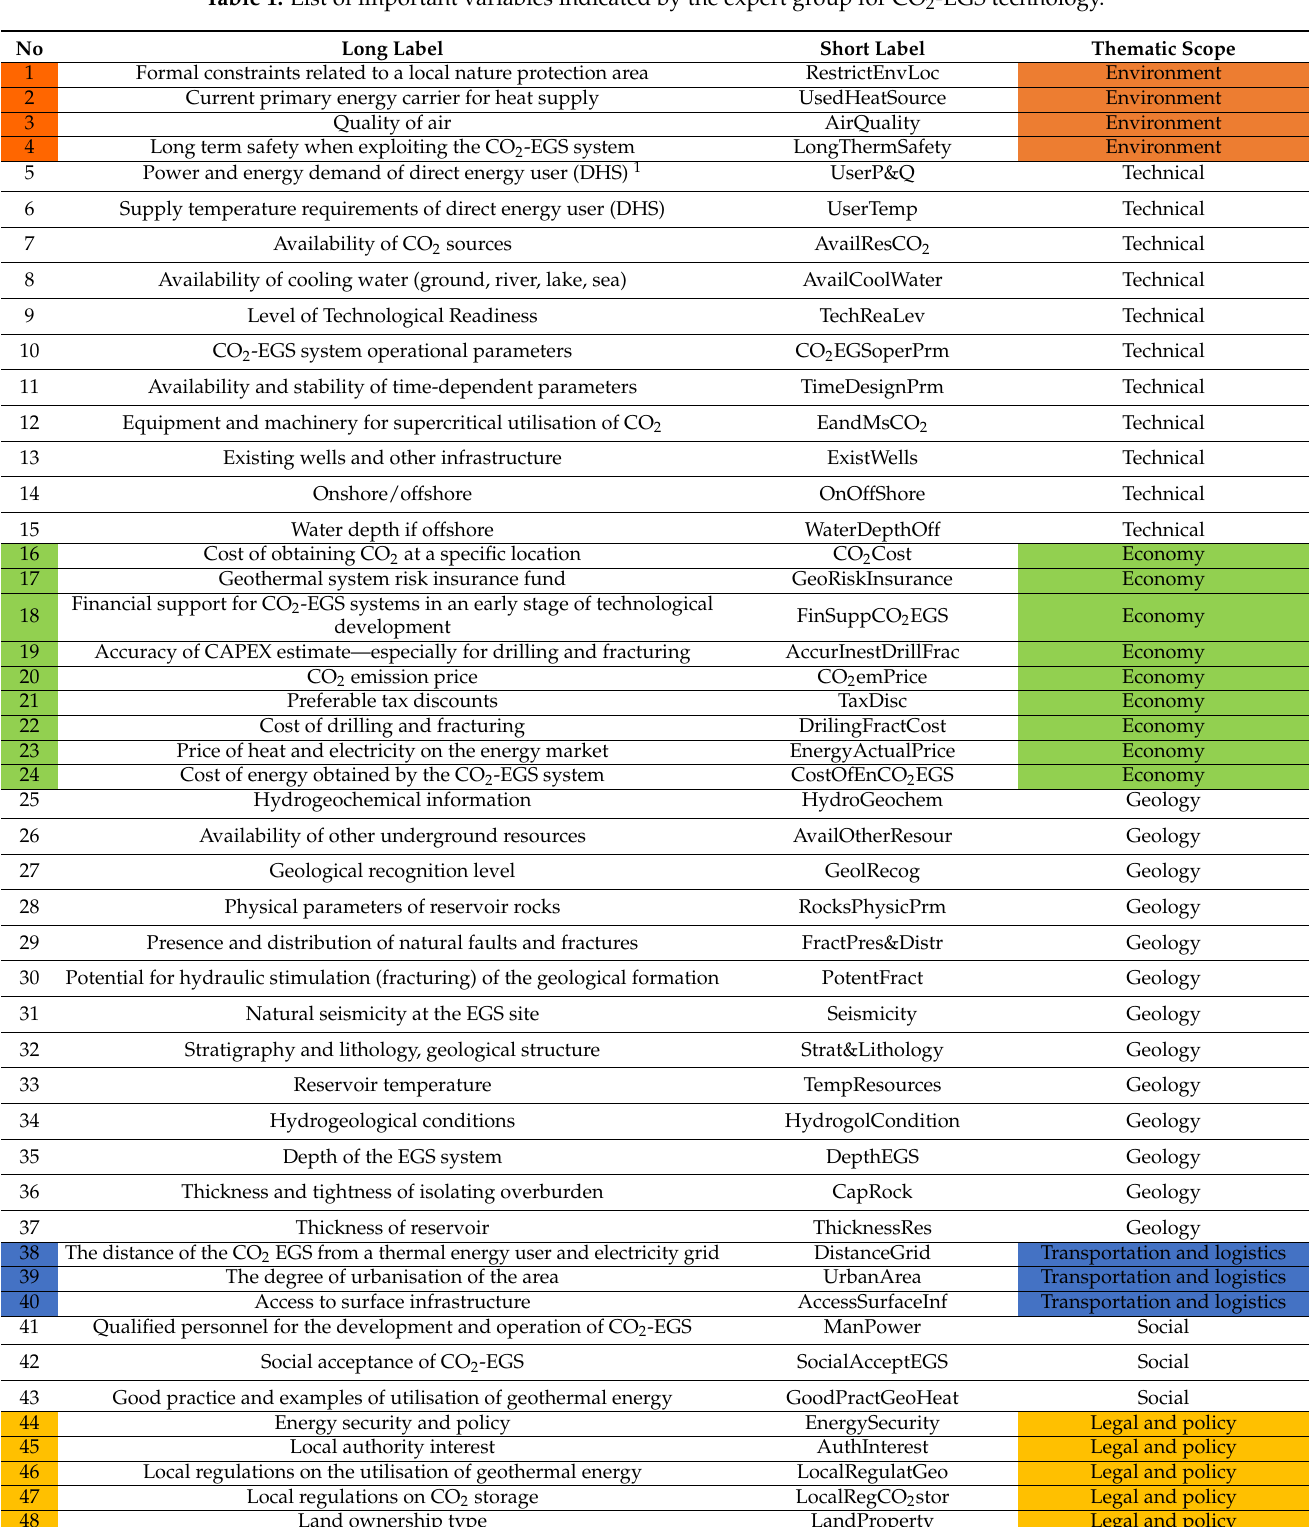
Table 1. List of important variables indicated by the expert group for CO 2 -EGS technology. No Long Label Short